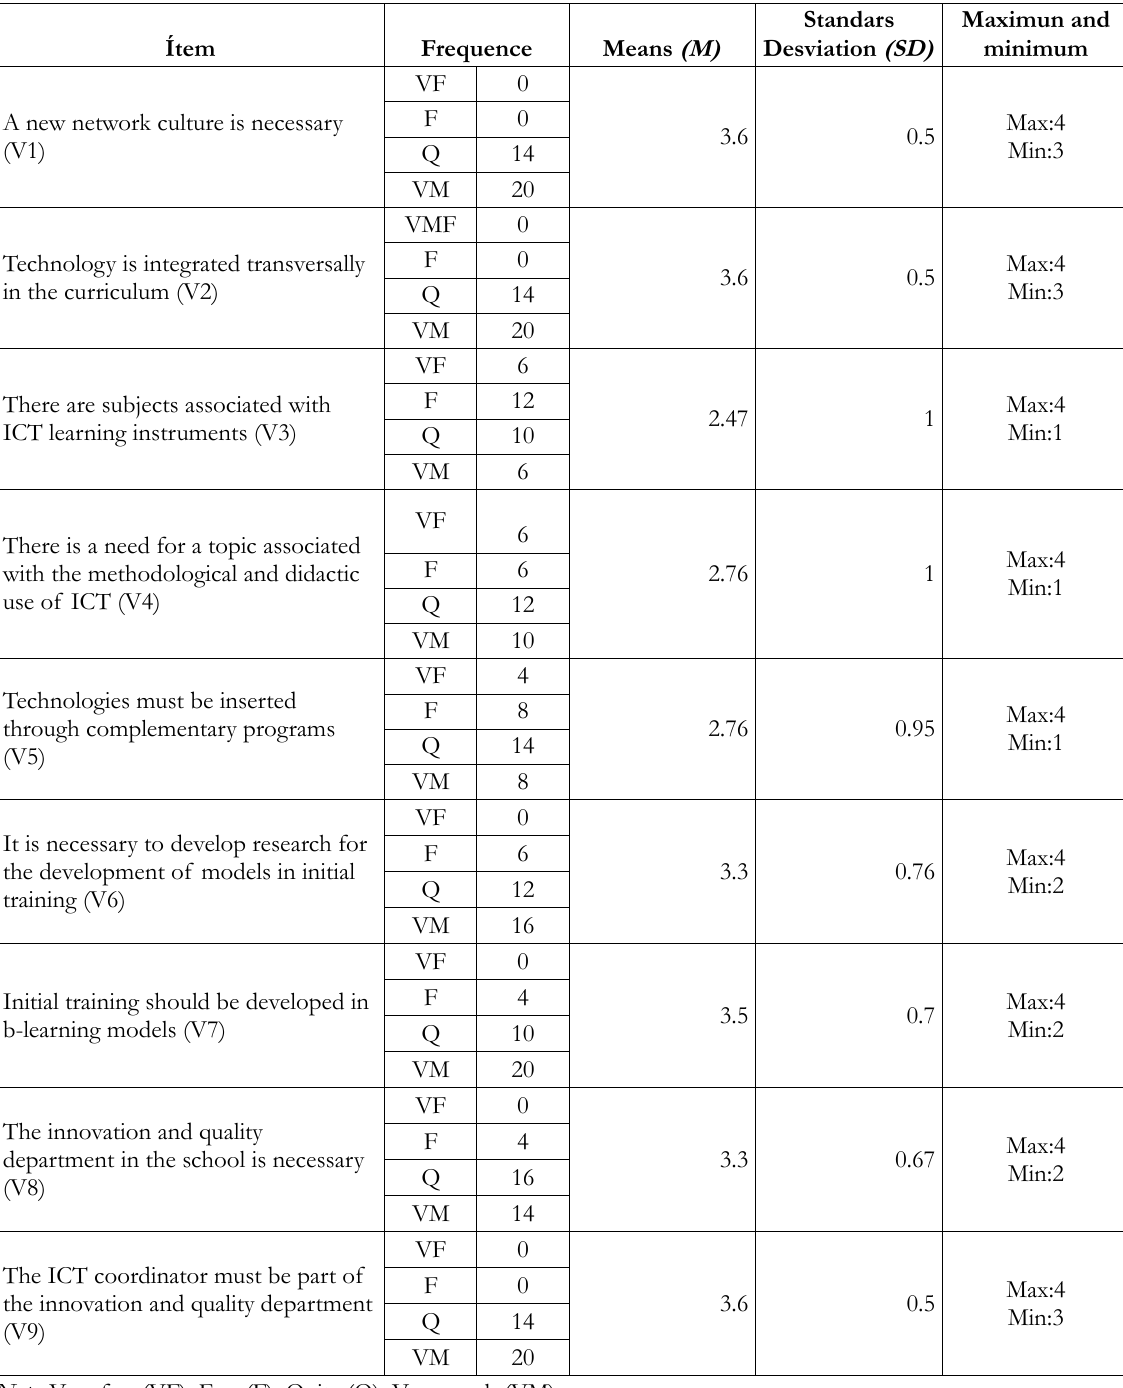
Table 5. Dimension values linked to organisational strategies and the application of